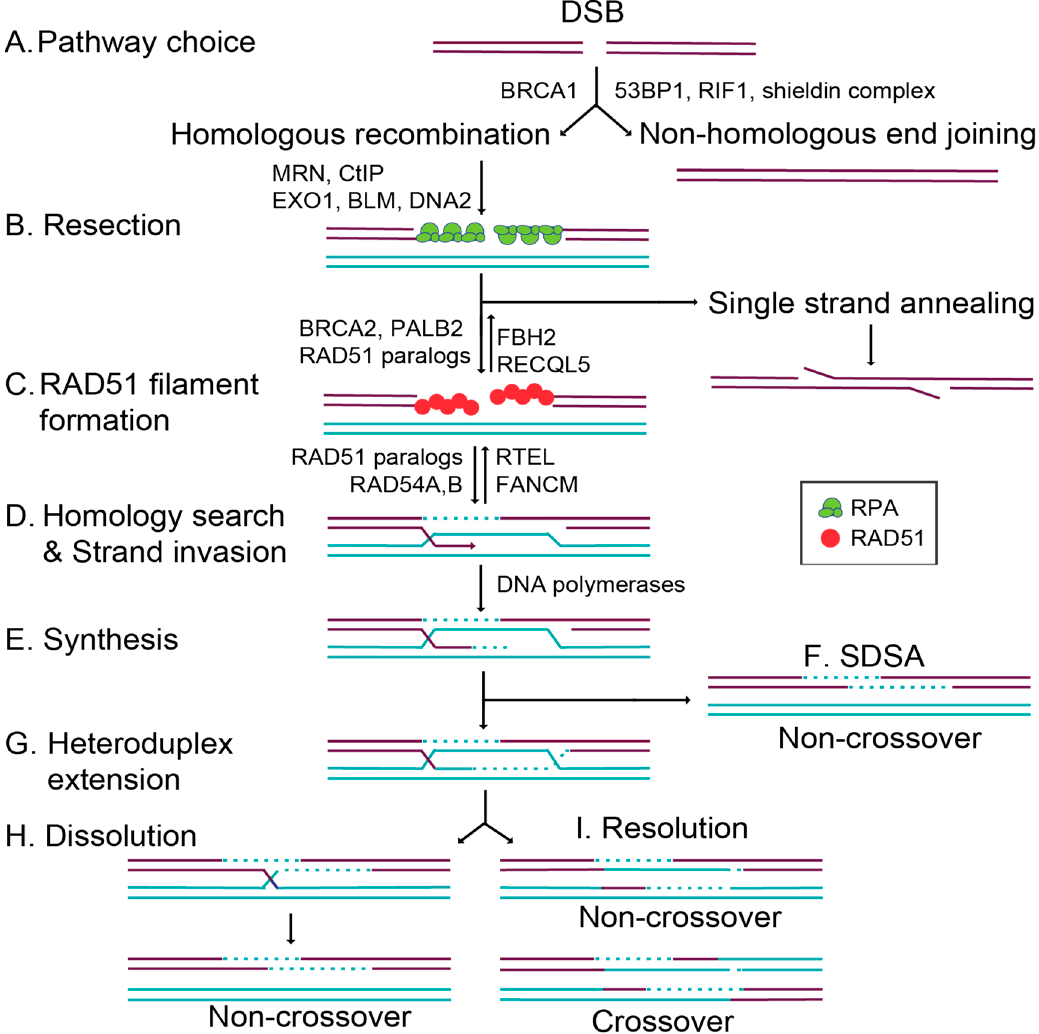
Figure 1. Schematic of double-strand break repair pathways and homologous recombination (HR). After the formation of a double-strand break (DSB; purple lines), cells can repair the damage through two primary mechanisms, HR using a homologous template (turquoise lines) or nonhomologous end joining (NHEJ). ( A ) Pathway choice between HR or NHEJ is mediated by BRCA1, which promotes HR and 53BP1, RIF1, and the shieldin complex, which promotes NHEJ. ( B ) Resection by the MRN (MRE11–RAD51–NBS1) complex, CtIP, EXO1, BLM, and DNA2 creates 3 ′ ssDNA overhangs, which are coated by the trimeric replication protein A (RPA) [20] complex (green circles). During canonical HR, RPA is displaced by RAD51 (red circles). Alternatively, RAD51-independent repair can occur through single-strand annealing, where complementary DNA sequences anneal, flap endonucleases cleave the overhang, and the DNA ends are ligated together. ( C ) RAD51 filament formation is regulated by the positive RAD51 regulators, BRCA2, PALB2, and the RAD51 paralogs. At the same time, RAD51 is negatively regulated by FBH2 and RECQL5. ( D ) RAD51-mediated homology search and strand invasion then occurs, and is regulated by the RAD51 paralogs and RAD54A,B. At the same time, RAD51-mediated D loops are negatively regulated by RTEL and FANCM. ( E ) The DNA polymerases then copy the missing information from the homologous template (shown in turquoise, a sister chromatid or a homologous chromosome). ( F ) During synthesis-dependent strand annealing (SDSA), the D loop is displaced, and the DNA is resolved into a noncrossover product. ( G ) If there is heteroduplex extension and a double Holliday junction formed by second-end capture, then these DNA intermediates can be resolved by dissolution or resolution. ( H ) Dissolution results in non-crossover products. ( I ) Resolution results in both crossover and non-crossover products.